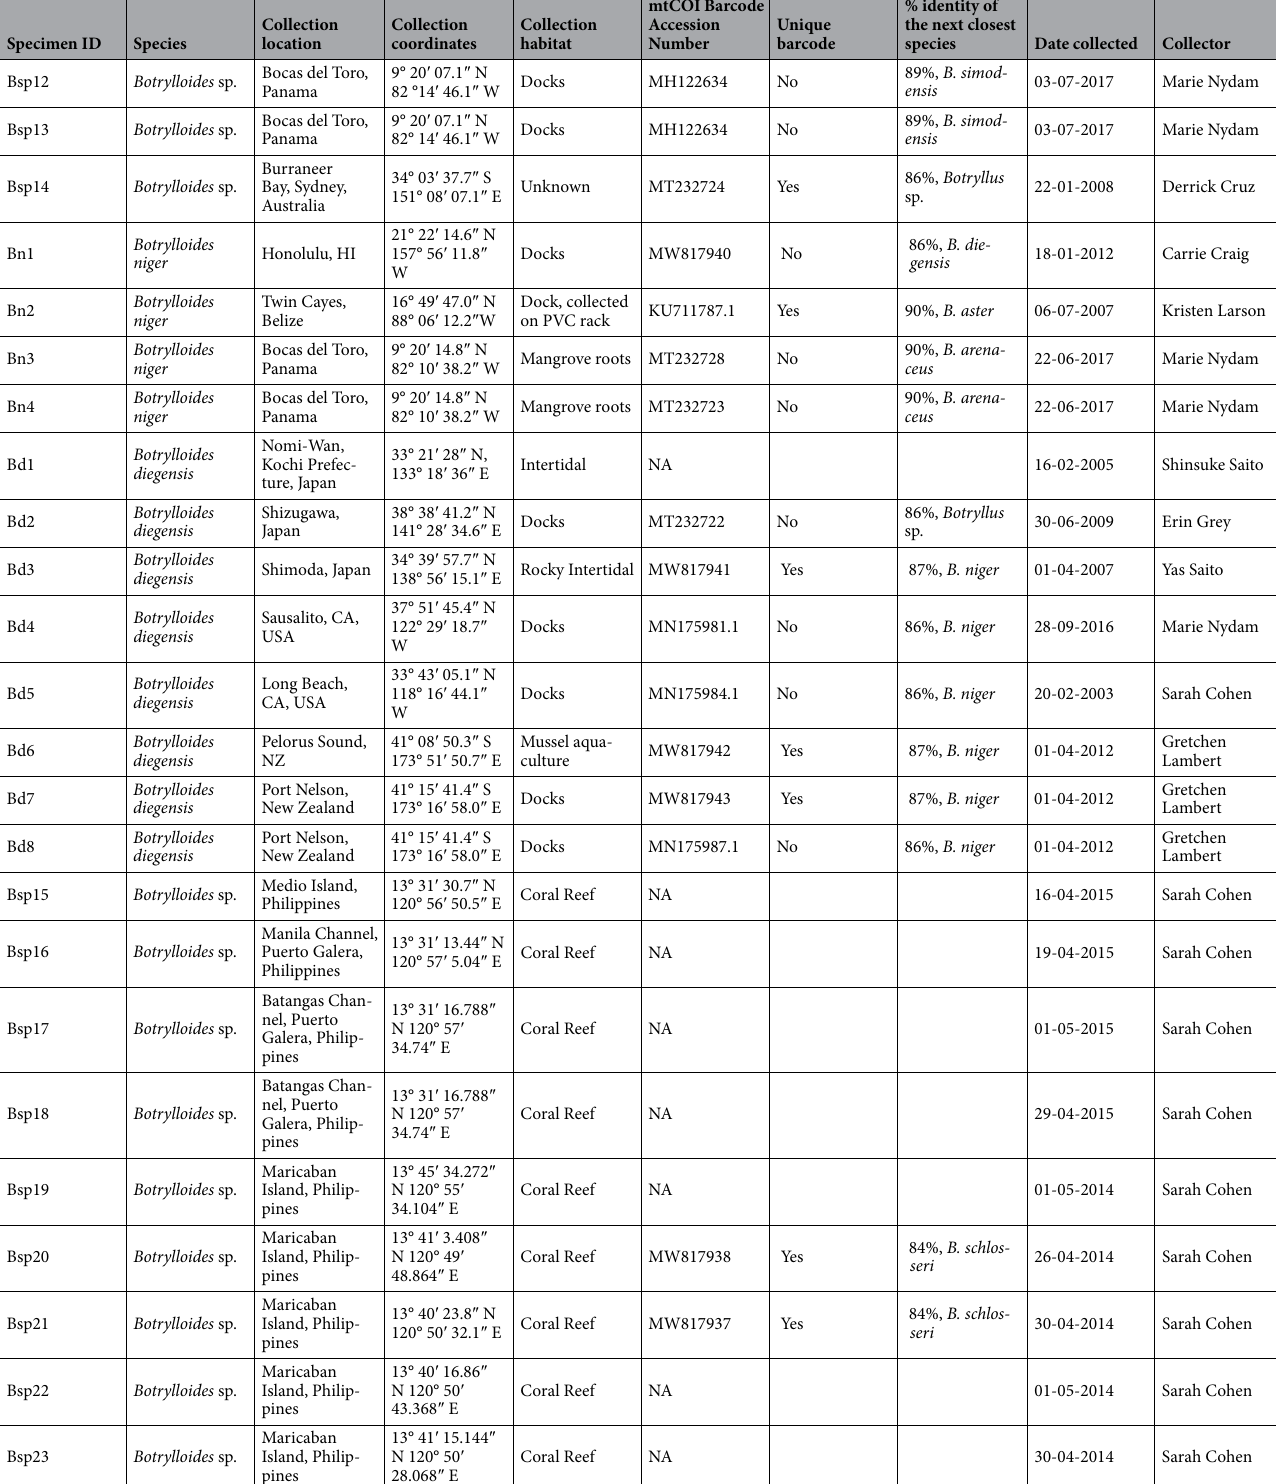
Table 1. Collection information for the 55 samples included in phylogenomic